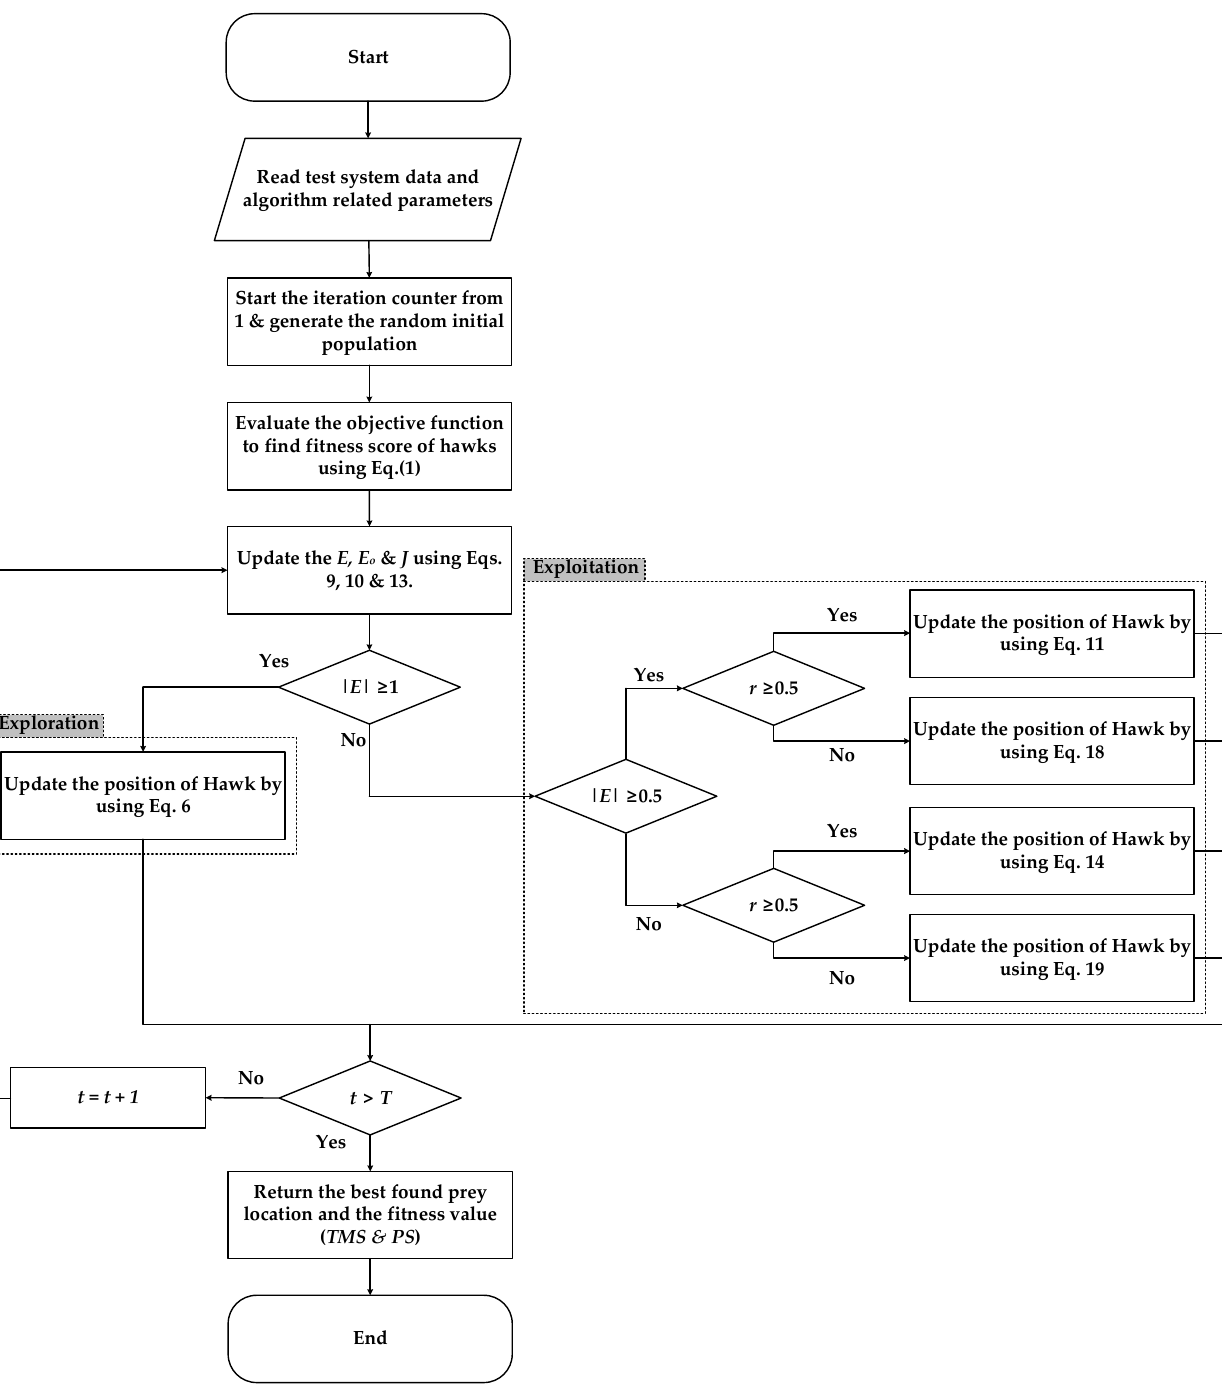
Figure 6. Flowchart of HHO.